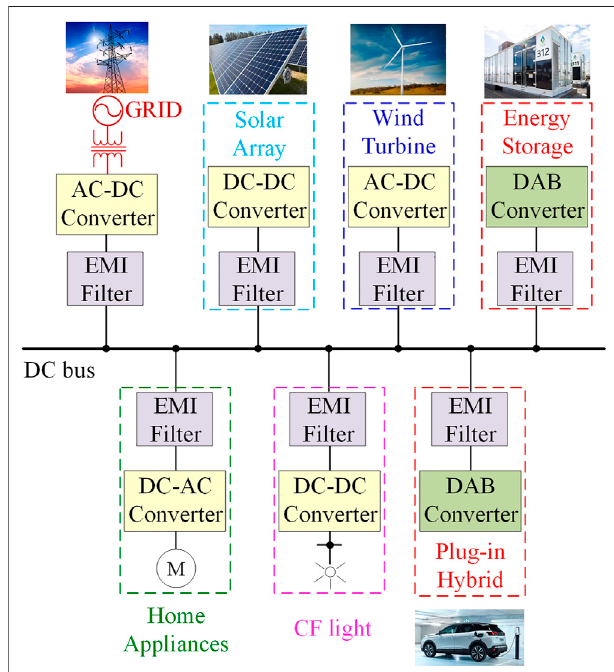
FIGURE 1 | System con fi guration of a DAB converter enabled dc